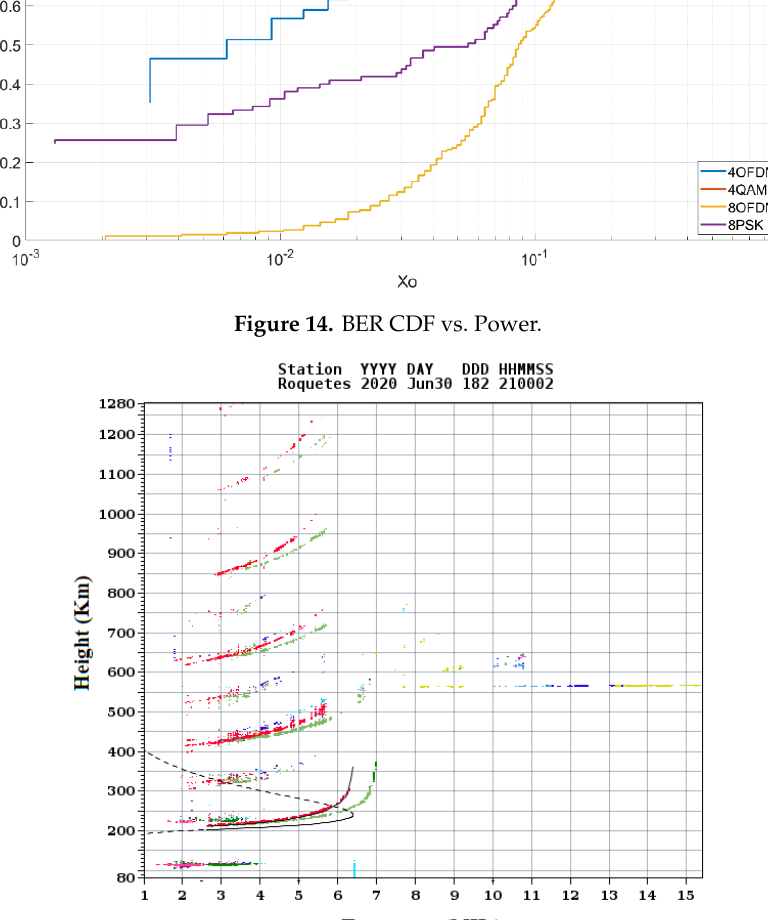
Figure 15. Ionogram at 20 UTC.